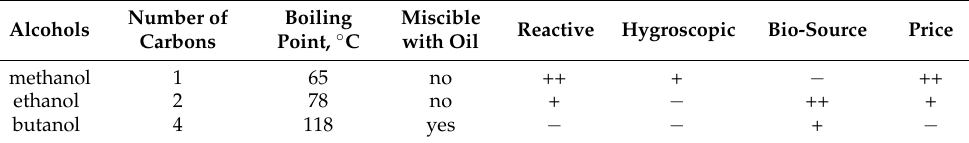
Table 3. Properties of alcohols are the most often used for transesterification.